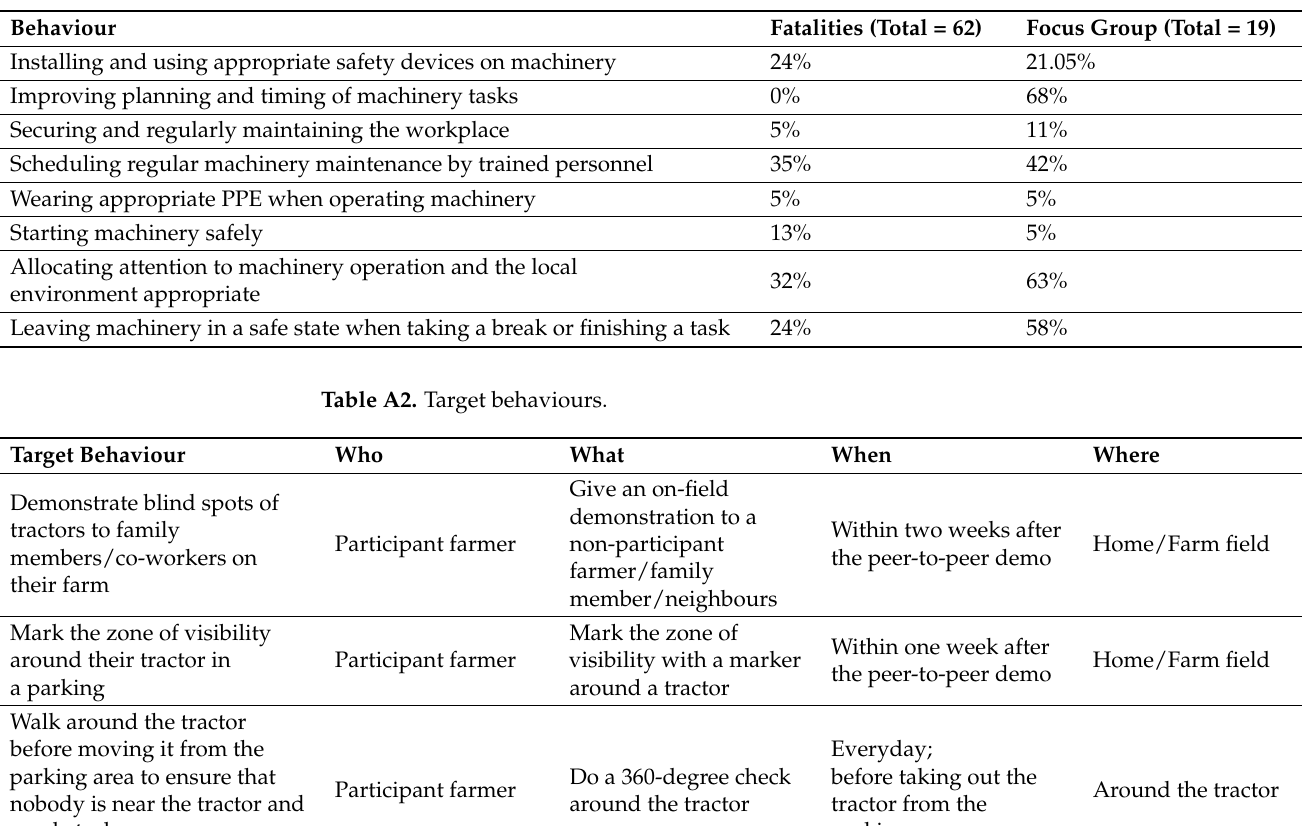
Table A1. Target behaviour categories (survey item) identified for the co-design workshops along with the number of reported fatalities associated with it and the percentage of farmers mentioned it in the focus group.